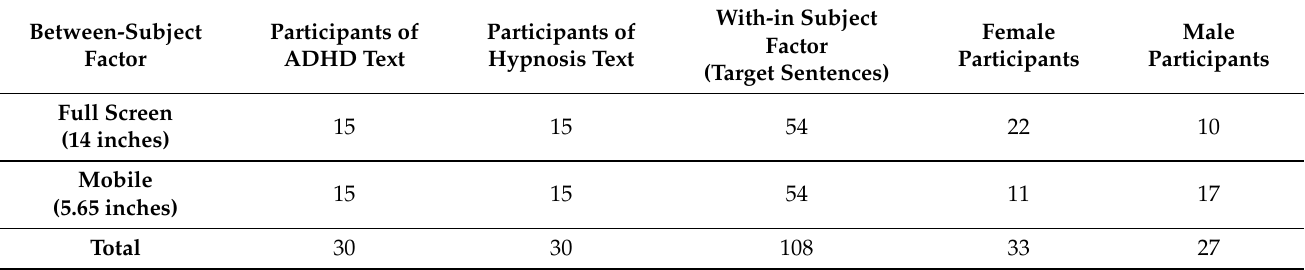
Table 1. Quantitative data of the